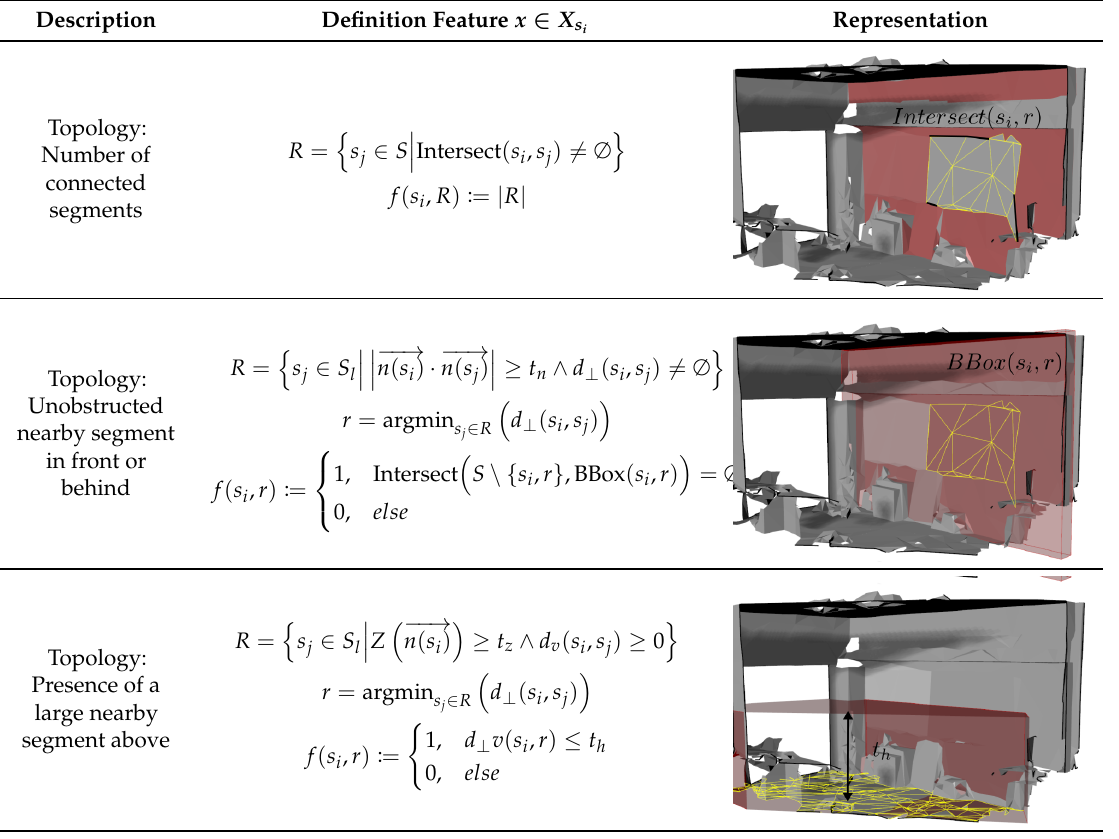
Table 4. The topology features extracted from each s i ∈ S with respect to a nearby reference segment r .